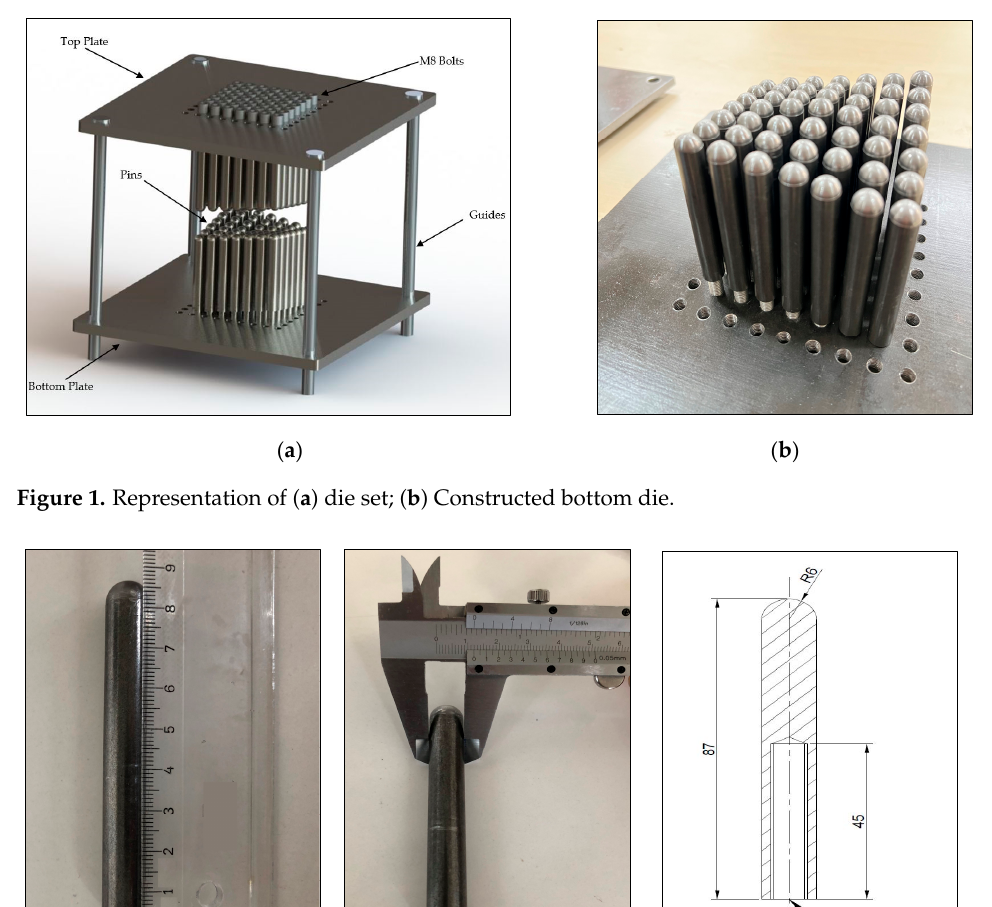
Table 1. Chemical composition of the sheet, as supplied.